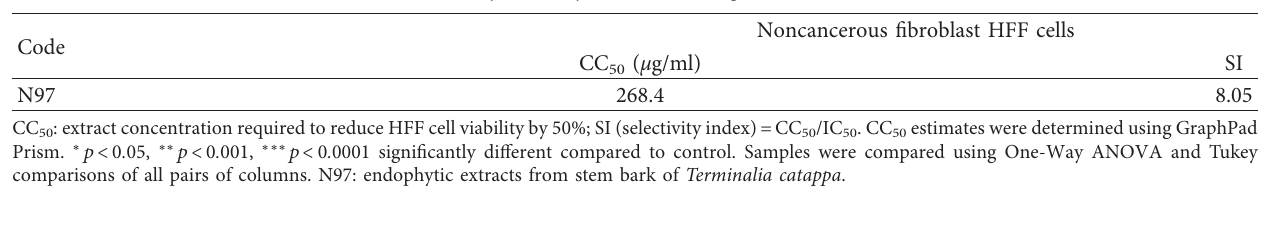
Table 3: Cytotoxicity effect of N97 against HFF cells.